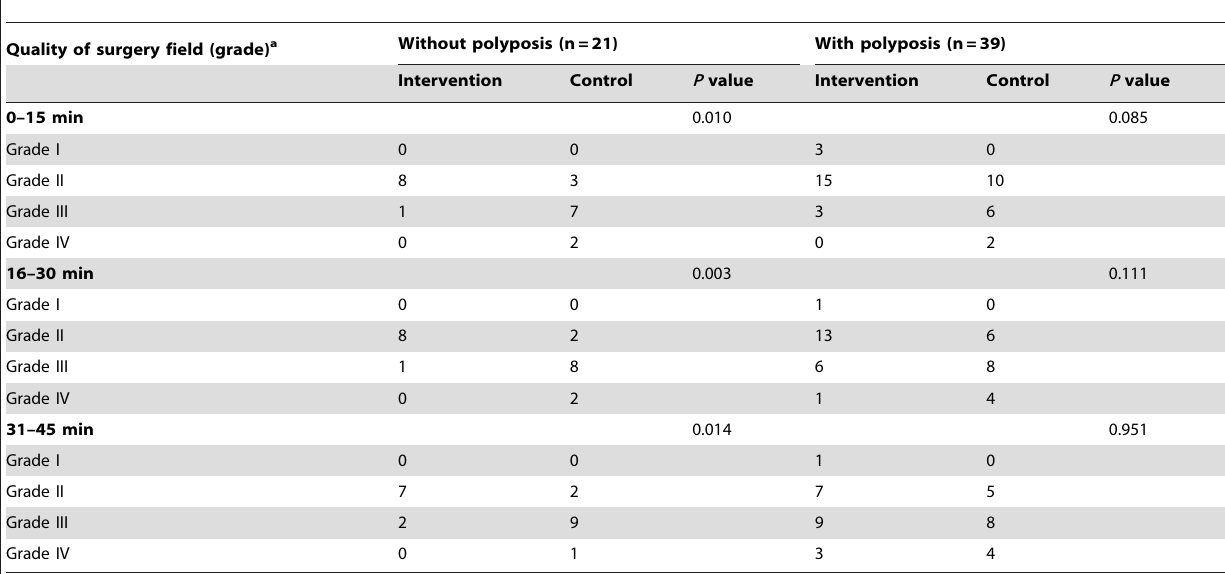
Table 5. Effect of tranexamic acid plus phenylephrine versus phenylephrine alone on quality of surgery field by duration of time and with or without polyposis using Fisher exact test.